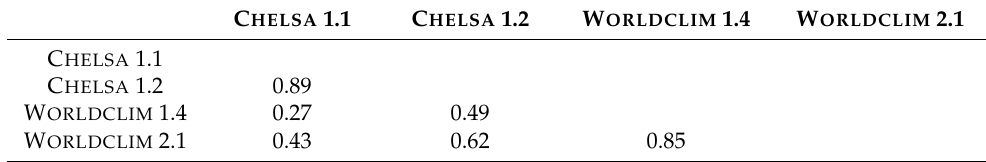
Table 4. Spearman rank correlation coefficients of Mean Temperature of the Wettest Quarter for all climate datasets and respective versions. All correlations were highly significant ( p ≤ 0.001) (Precipitation in March, April,